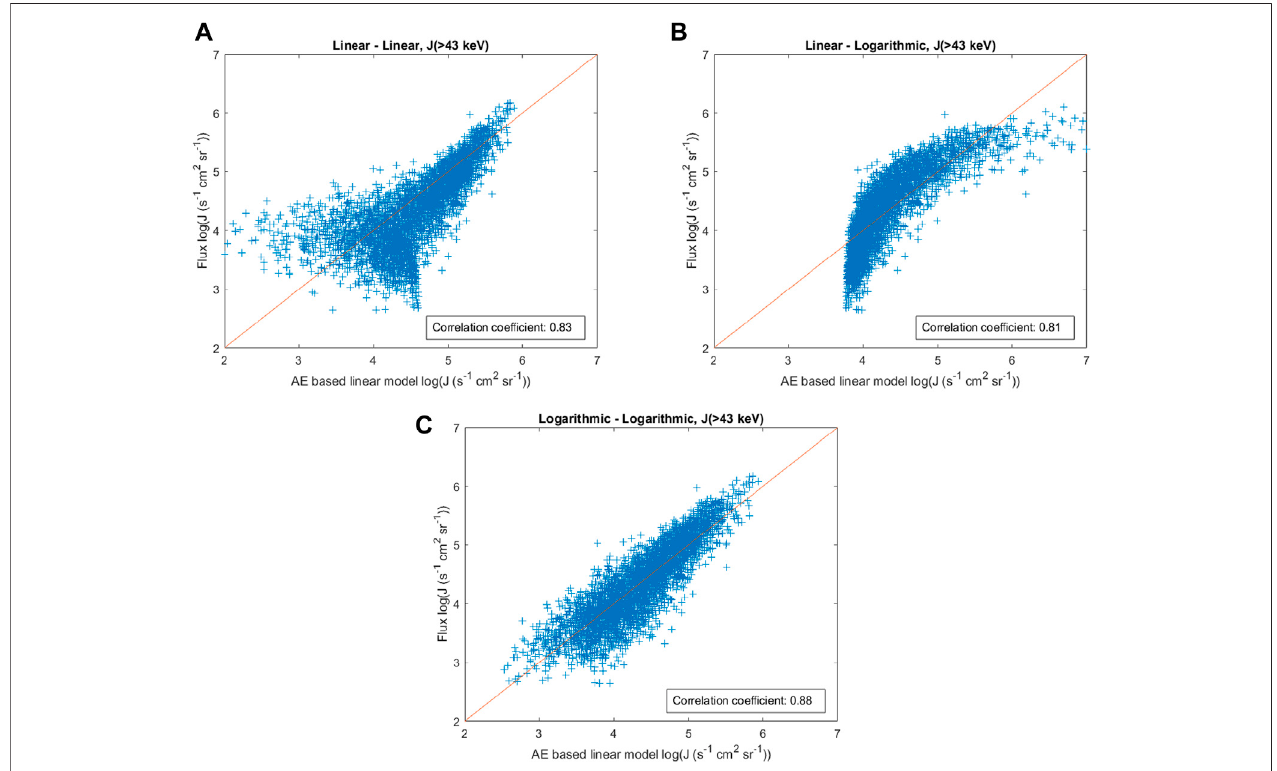
FIGURE 4 | Scatter plots and a linear fi t of (A) the linear value of the daily AE index and linear value of the daily > 43 keV fl uxes (Linear-Linear), (B) the linear value of the daily AE index and logarithmic value of the daily > 43 keV fl uxes (Linear-Logarithmic), and (C) the logarithmic value of the daily AE index and logarithmic value of the daily > 43 keV fl uxes (Logarithmic-Logarithmic).